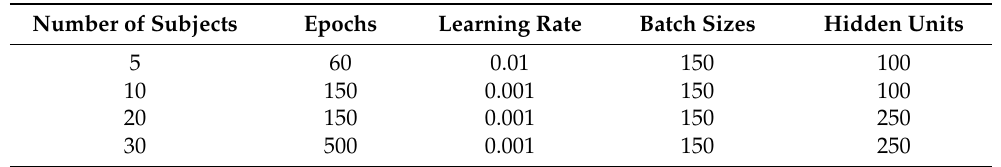
Table 1. LSTM hyperparameters definition in our UA Solution for training part in four different